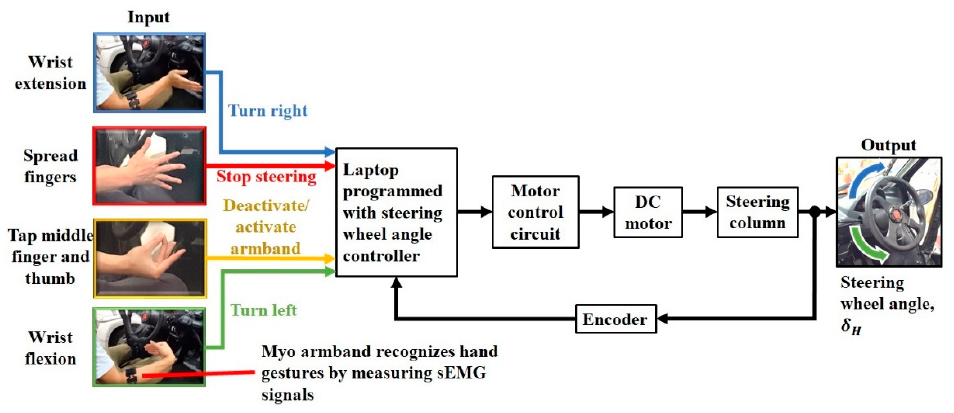
Figure 2. Steering assistance control scheme.